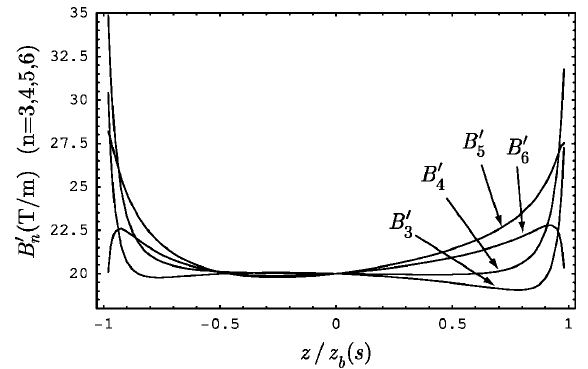
FIG. 8. Strength of the 3rd, 4th, 5th, and 6th magnets as functions of z